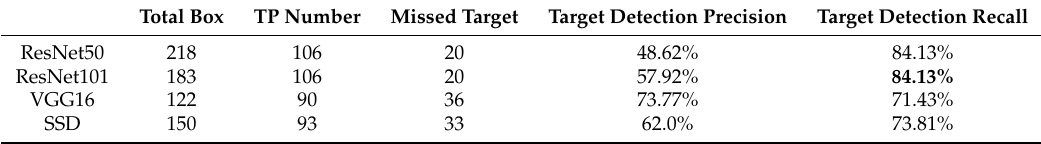
Table 3. Target detection algorithm